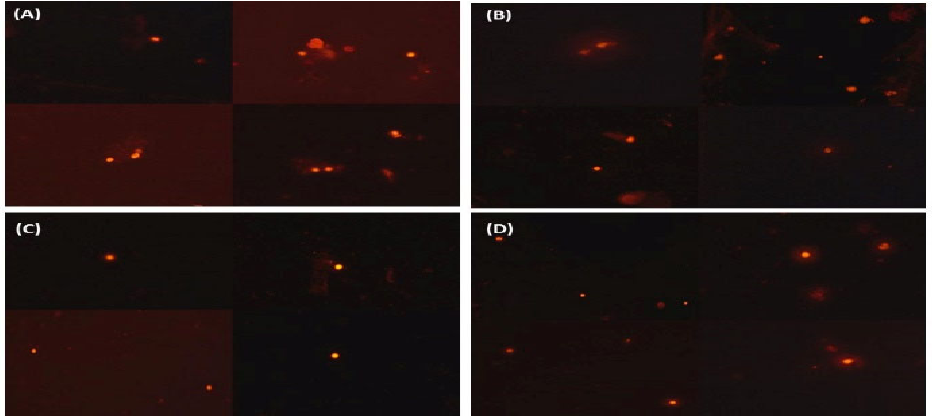
Figure 3. Photomicrographs showing the effect of feeding Muscovy ducks ( C. moschata) with a diet supplemented with S. marianum dry seeds at different levels (4, 8, 12 g kg − 1 diet) and control on comet assay in duck liver at the end of the experiment. ( A ) is the control group, which showed a positive comet and clear shadow in the liver cells; ( B ) is the group that received a diet with low S. marianum dry seeds dose (4 g kg − 1 diet), showed a positive comet and light shadow in the liver cells; ( C ) is the group which received a diet with medium S. marianum dry seeds dose (8 g kg − 1 diet) ; it did not show positive comet or shadow in the liver cells, and ( D ) is the group which received a diet with high S. marianum dry seeds dose (12 g kg − 1 diet) ; it did not show positive comet or shadow in the liver cells.